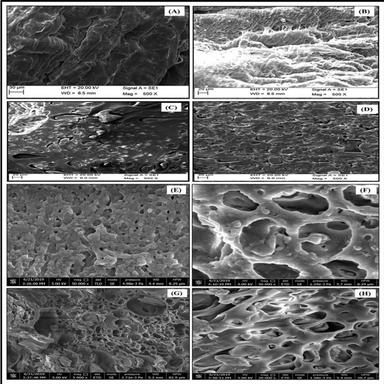
SEM and FESEM micrographs for morphological study of the surface of novel hybrid BSM: (A) without lipase; (B) with lipase, and cross section of the hybrid BSM; (C) without lipase; (D) with lipase; FESEM for (E) without lipase; (F) with lipase, and cross section of the hybrid BSM; (G) without lipase; (H) with lipase.